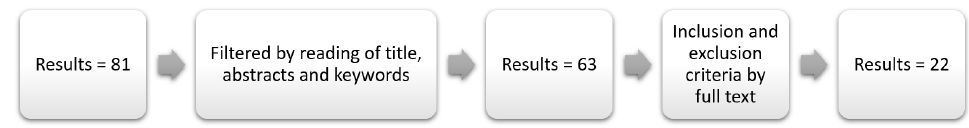
Figure 5. Data filtering process and inclusion/exclusion